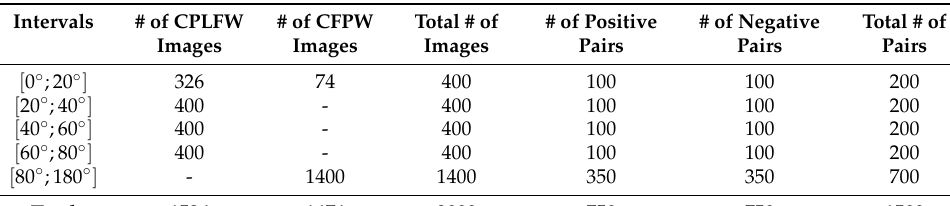
Table 4. Number of images and pairs per interval of each dataset used to build the proposed evaluation subset.